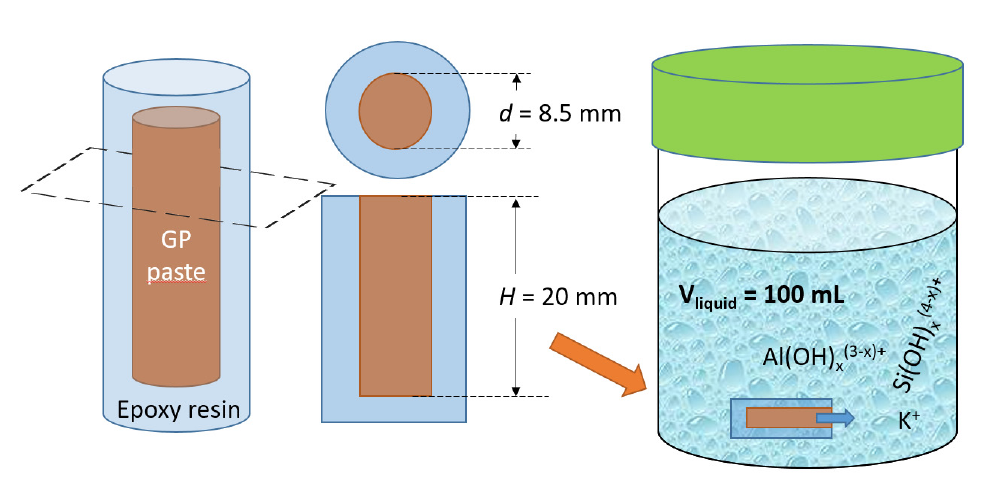
Figure 2. A scheme of the one ‐ dimensional diffusion leaching test: cylindrical geopolymer specimens are immersed in 100 mL solution for up to 56 days of exposure, where the solution was replaced with a fresh one in ten time